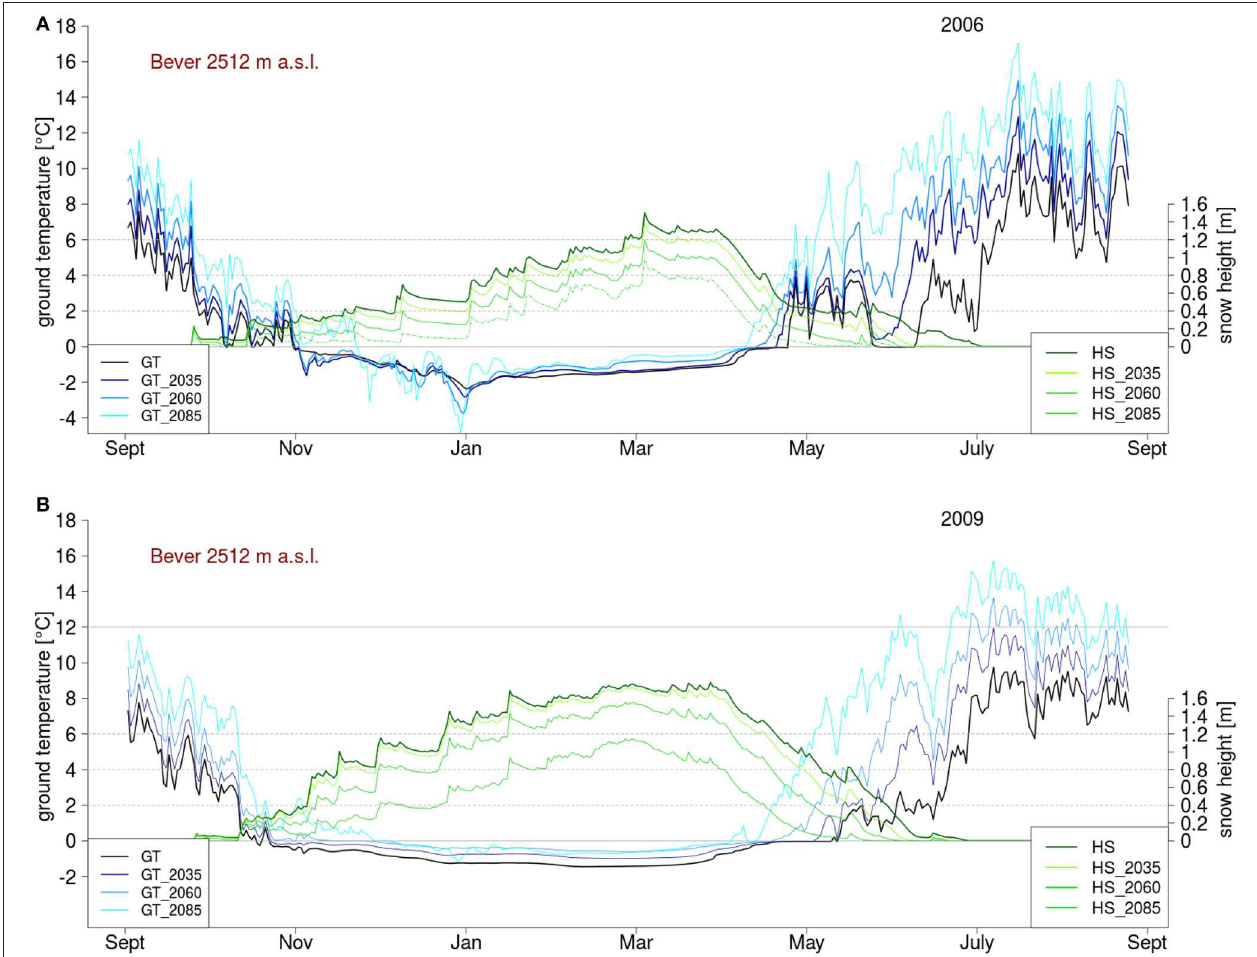
FIGURE 6 | Example of a snow-poor year ( A , 2006) where a cooling of the ground in early winter can be seen and a snow-rich year ( B , 2009) with no cooling effect for the Bever-station in Grison. Snow height (HS) is in greenish colors and ground temperature (GT) in blue.